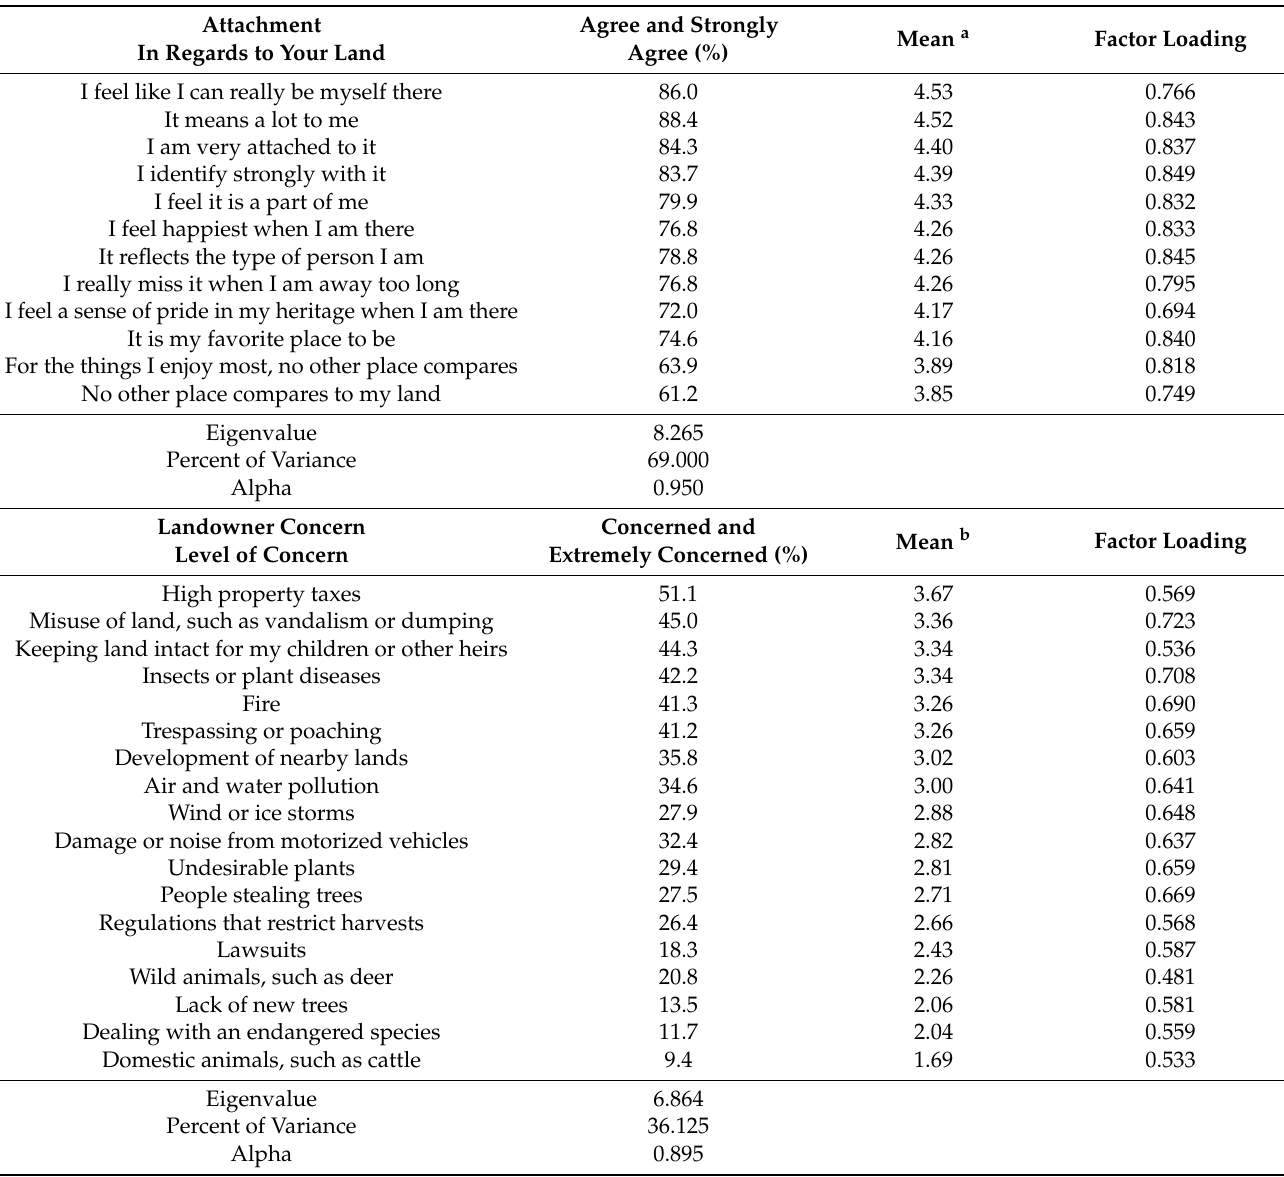
Table 2. Factor analysis of place attachment and landowner concern